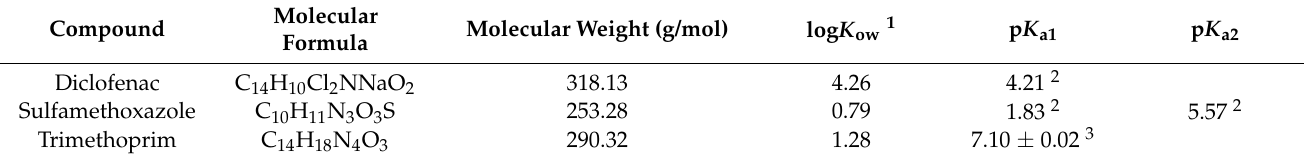
Table 7. Physicochemical properties of the selected pharmaceuticals. J Chem for Office (20.11.0, ChemAxon, https://www.chemaxon.com, accessed on 11 June 2021) was used for calculating the physicochemical properties (molecular weight and log K ow ). Values for p K a1 and p K a2 were obtained from the literature